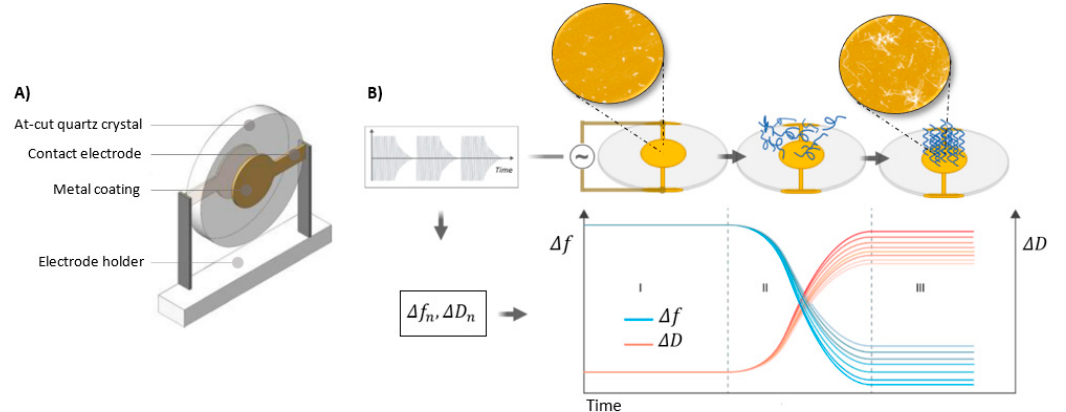
Figure 2. ( A ) Basic scheme of QCM sensor consisting of a piezoelectric AT-cut quartz crystal coated with two gold electrodes, one on each side. ( B ) Schematic working principle provides information on variations in ∆ f and ∆ D plotted as molecules become adsorbed on gold sensor surface. In the schematic adsorption mechanism, section I shows a bare surface and stable baselines; during adsorption molecular changes in ∆ f and ∆ D are observed (section II). After complete adsorption on the surface, the baselines are stabilized (section III). The collected quartz crystal microbalance with dissipation monitoring (QCM-D) data can be used for viscoelastic modelling and quantification of mass, as well as calculating the viscoelasticity and thickness of the adsorbed layer .